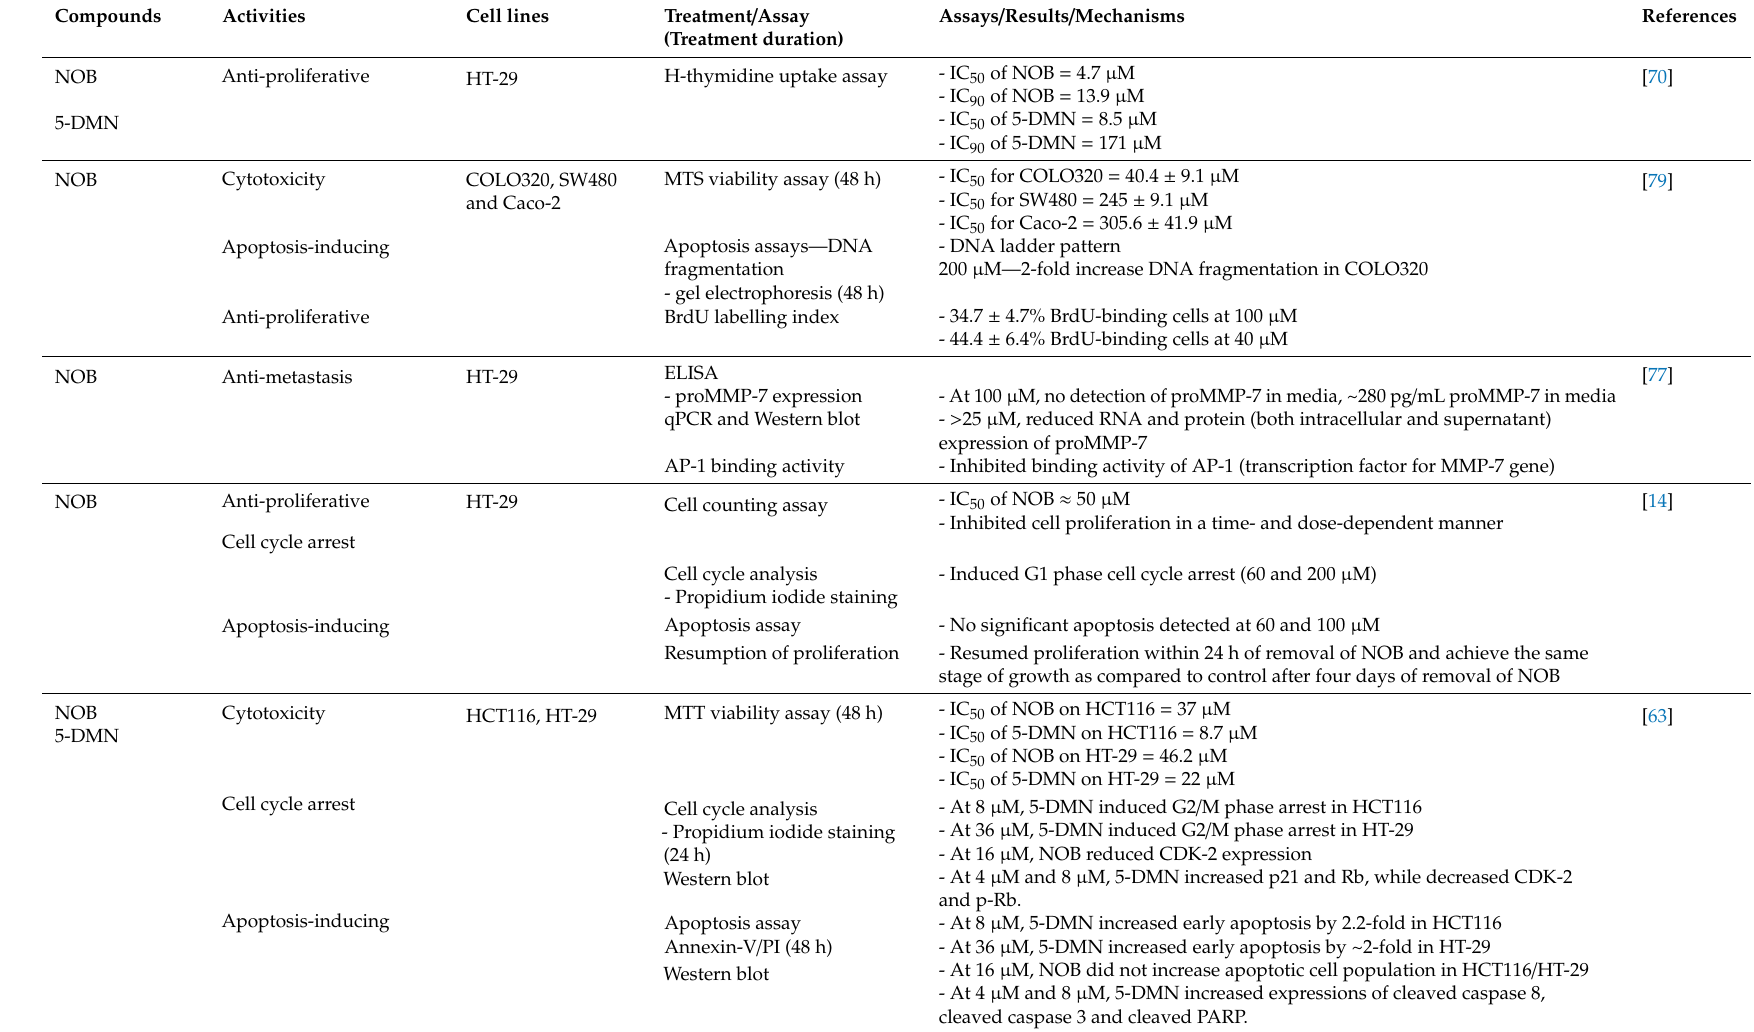
Table 1. In vitro chemopreventive properties of NOB, 5-DMN and